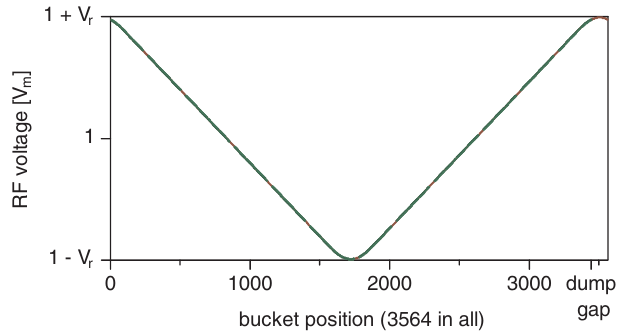
FIG. 14. (Color) Possible rf AM shape for LHC, considering the filling